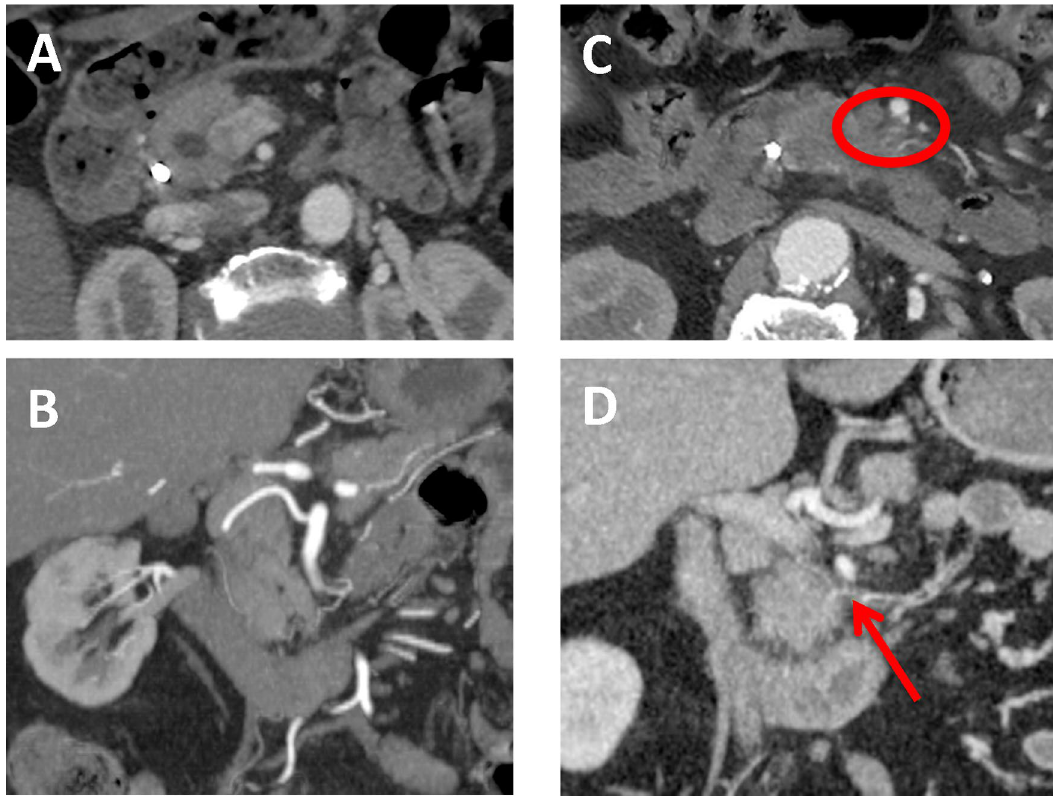
Figure 2. CT-examinations of two different patients without CT-signs of perineural invasion ( A , B ) and with CT-signs of perineural invasion ( C , D ) obtained with intravenous contrast material. Axial MIP scans ( A ) and oblique MIP coronal reformat ( B ) in arterial phase demonstrate normal fatty tissue surrounding IPDA which suggests the absence of perineural spread. Axial MIP scans ( C ) and oblique coronal reformat ( D ) in arterial phase demonstrate the areas with soft tissue attenuation surrounding IPDA (red circle and red arrow), reported as suspicious for perineural invasion.